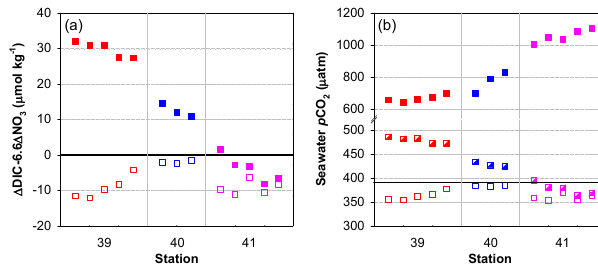
Figure 5. Panel (a) shows (cid:49) DIC − 6.6 (cid:49) NO 3 and (b) shows seawa- ter p CO 2 in the surface mixed layer at stations 39–41 on transect 5 near the Oregon–California border in spring/early summer 2007. In (a) , open symbols indicate values estimated based on the two- end-member mixing between the upwelling source water and the rainwater, while filled symbols indicate values after removing the rainwater. The value of 6.6 is the Redfield C/N uptake ratio (ap- proximately 106 / 16; Redfield et al., 1963). The solid line indicates the p CO 2 equilibrium between the seawater and the atmosphere. In (b) , the open and semi-filled symbols denote the estimated sea surface p CO 2 from (cid:49) DIC − 6.6 (cid:49) NO 3 on top of the mixing with and without rainwater, respectively. The filled symbols denote the field-observed sea surface p CO 2 , which were obtained by applying TAlk and DIC data into the CO2SYS program (Lewis and Wallace, 1998). The solid line denotes the atmospheric p CO 2 of ∼ 390µatm (Evans et al.,